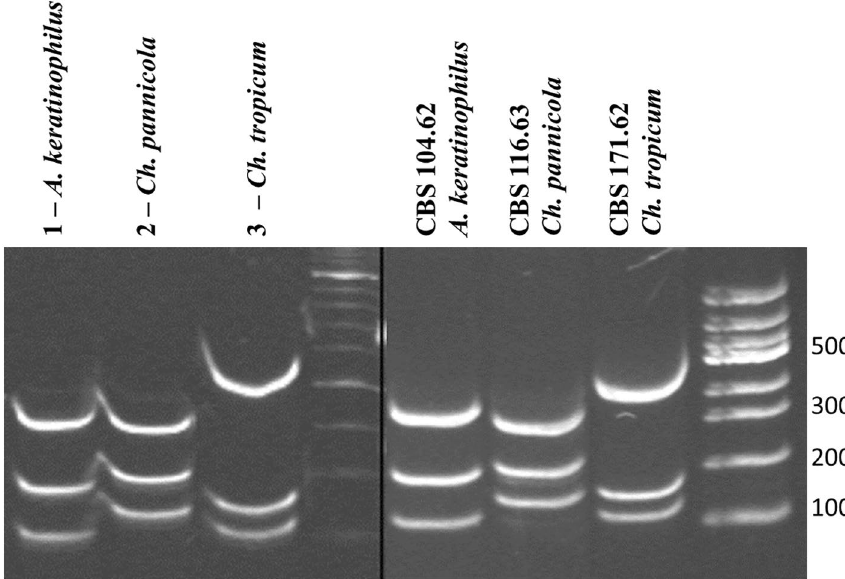
Figure 1. Exemplary polyacrylamide-gel electrophoresis of PCR products digested with Hin fI restriction enzyme. The ITS1-ITS4 set of primers was used to amplify the ITS1-5.8SrDNA-ITS2 region. Profiles A–C are characteristic of Aphanoascus keratinophilus , Chrysosporium pannicola and Chrysosporium tropicum , respectively. Abbreviations above lanes (1–3) correspond to the species names assigned during traditional identification. Full-length gels are shown in Supplementary Fig.